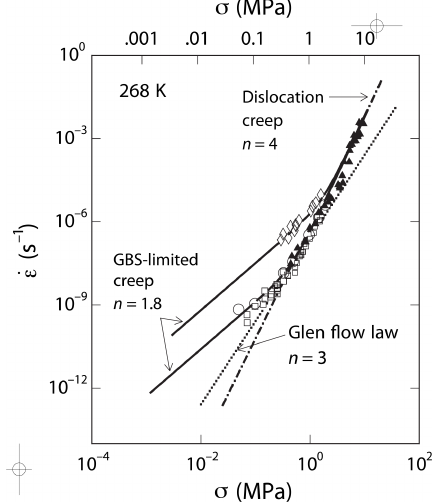
Figure 1. Strain rate versus stress compiled from laboratory exper- iments on coarse-grained ice revealing the existence of the disloca- tion creep regime ( n = 4) and GBS-limited creep regime ( n = 1.8) at high and low stress, respectively. The upper and lower solid lines show a grain boundary sliding flow law calculated for grain sizes of 0.2 and 2mm, respectively; the dashed–dotted line shows the dis- location creep flow law; the dotted line depicts the Glen law. Data are from ambient pressure tests at 268K: d = 0.2mm (diamonds) (Goldsby and Kohlstedt, 2001); d ≥ 1mm (squares) (Steinemann, 1958); d ≥ 1mm (circles) (Mellor and Smith, 1966); d ≥ 1mm (tri- angles; Barnes et al., 1971). Note that the Glen law fails to ade- quately describe the flow of ice over a wide range of stresses. Figure adapted from Goldsby